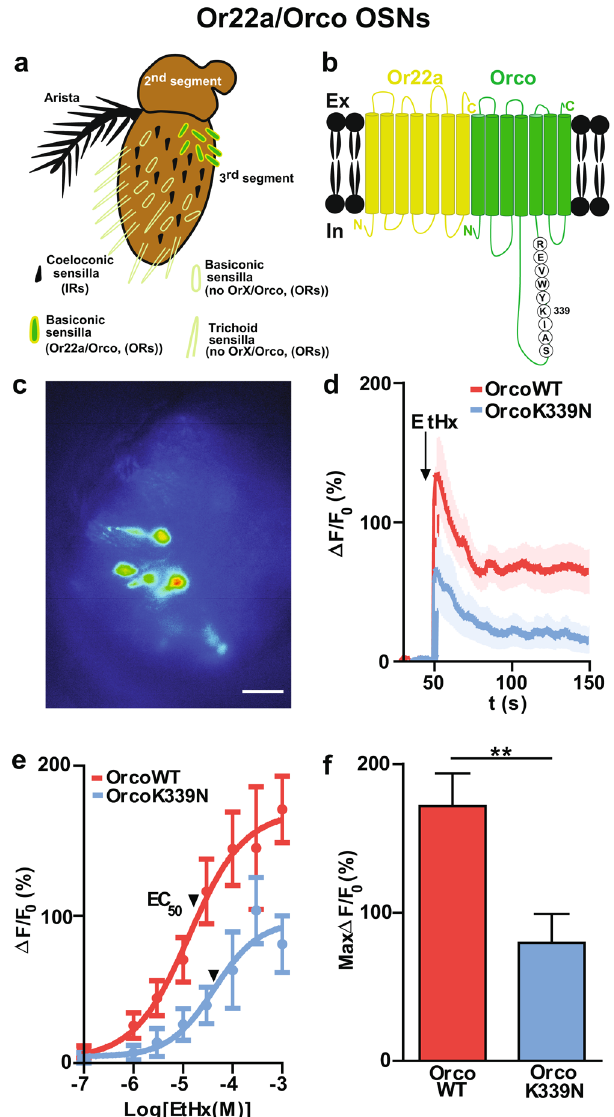
Figure 2. Effect of Orco CBS mutation on the odor response in solely Or22a/Orco expressing OSNs. (a) Scheme of a Drosophila melanogaster antenna. The third segment is covered with sensilla that house the dendrites of up to four OSNs. OSNs that express ORs (odorant receptor) are present in basiconic and trichoid sensilla and coeloconic sensilla house IR expressing OSNs. (b) Schematic view of insect ORs formed by heptahelical Or22a and Orco (co-receptor) proteins. The second intracellular loop of Orco contains the highly conserved CaM binding site 336 SAIKYWVER 344 . (c) GCaMP labelled fluorescence intensity of Or22a/Orco OSNs. (d) Time course of Ca 2+ fluorescence responses obtained OrcoWT OSNs and OrcoK339N OSNs upon OR stimulation with 100 µM ethyl hexanoate (n = 11 for OrcoWT, n = 11 for OrcoK339N). (e) Concentration response relationship for OrcoWT and OrcoK339N (8 ≤ n ≤ 10). Curves represent sigmoidal fits described by Hill coefficient 0.777 (OrcoWT), 0.9525 (OrcoK339N), and EC 50 of 13 µM (OrcoWT), 42 µM (OrcoK339N). (f) Maximum fluorescence response (Max ∆F/F 0 (%)) obtained by subtracting the base level at 50 s from the maximum Ca 2+ fluorescence at 1 mM ethyl hexanoate. n = number of antennae. Two-tailed unpaired t- test , ** P < 0.01. Data given as mean ± SEM. Scale bar of antenna: 20